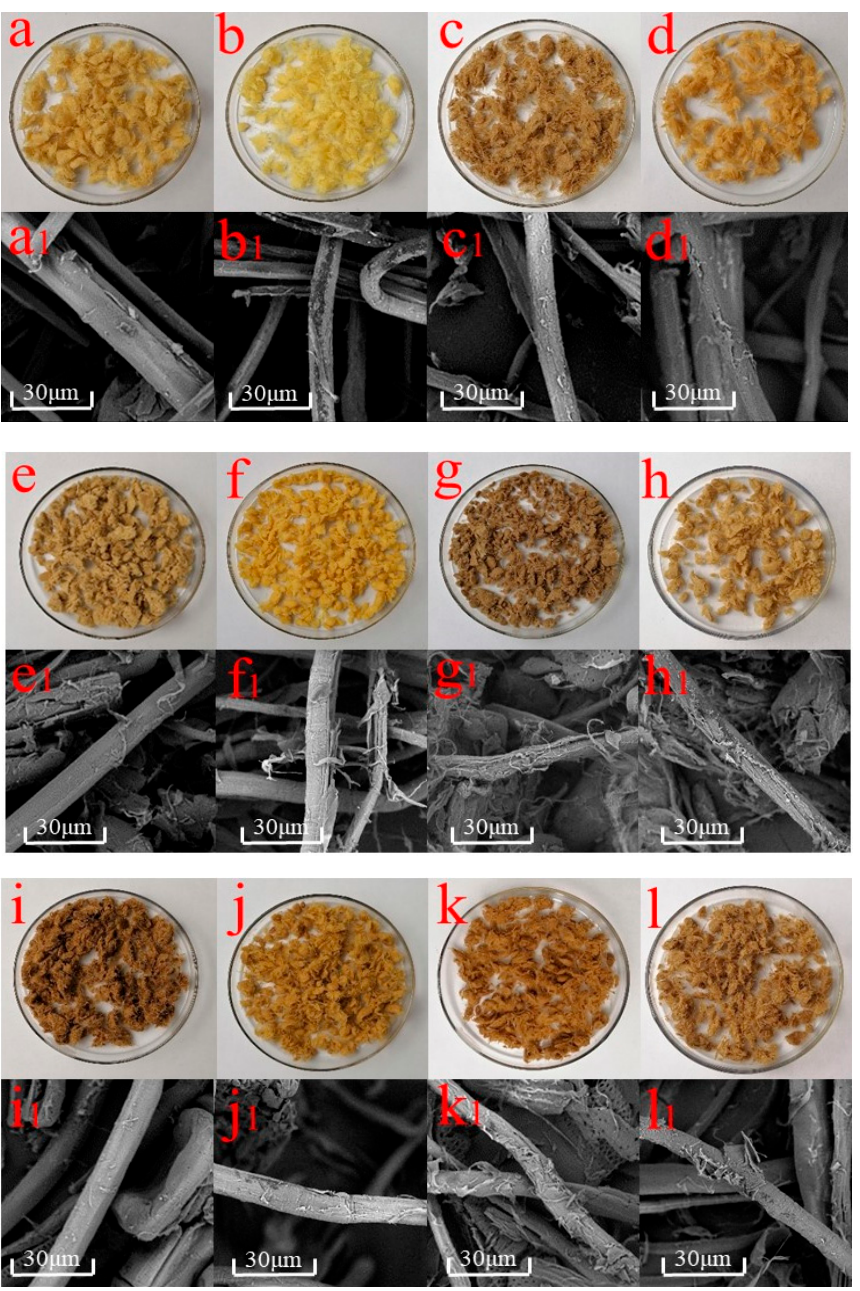
Figure 1. Photographs/SEM images (×2000) of samples: ( a , a1 ) hydrogen peroxide mechanical pulp (APMP) APMP; ( b , b1 ) H-APMP; ( c , c1 ) F-APMP; ( d , d1 ) E-APMP; ( e , e1 ) sulfonated chemical mechan- ical pulp (SCMP); ( f , f1 ) H-SCMP; ( g , g1 ) F-SCMP; ( h , h1 ) E-SCMP; ( i , i1 ) chemical thermomechanical pulp (CTMP); ( j , j1 ) H-CTMP; ( k , k1 ) F-CTMP; and ( l , l1 )